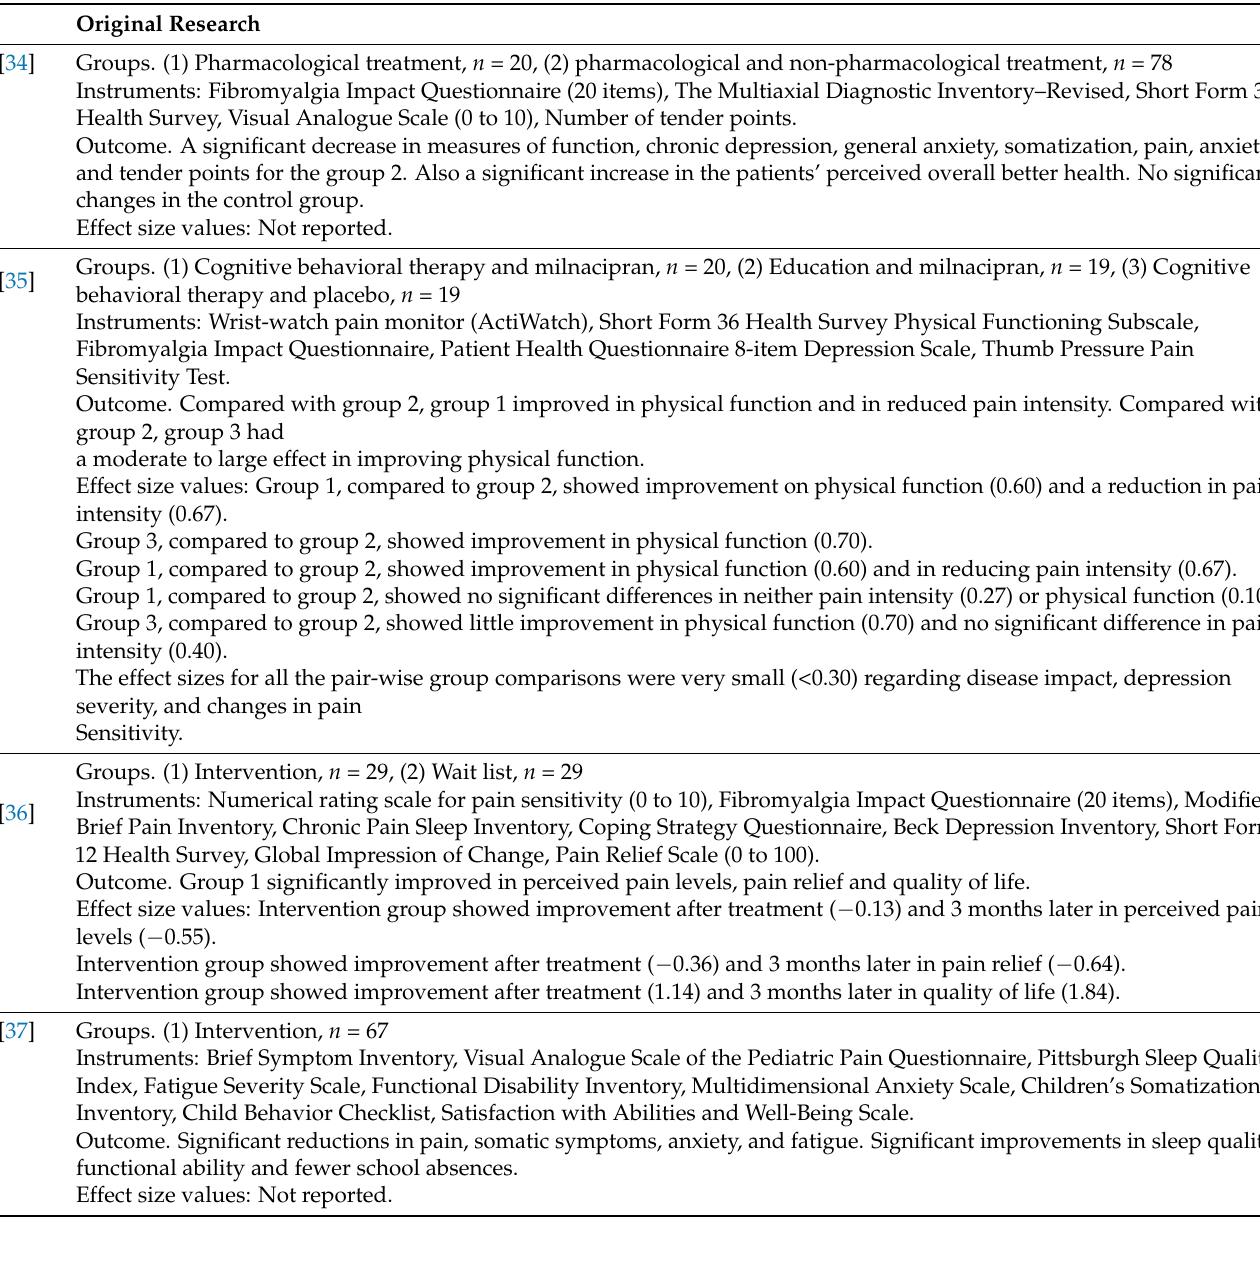
Table 3. Treatment groups, instruments, and significant results in the patients’ clinical